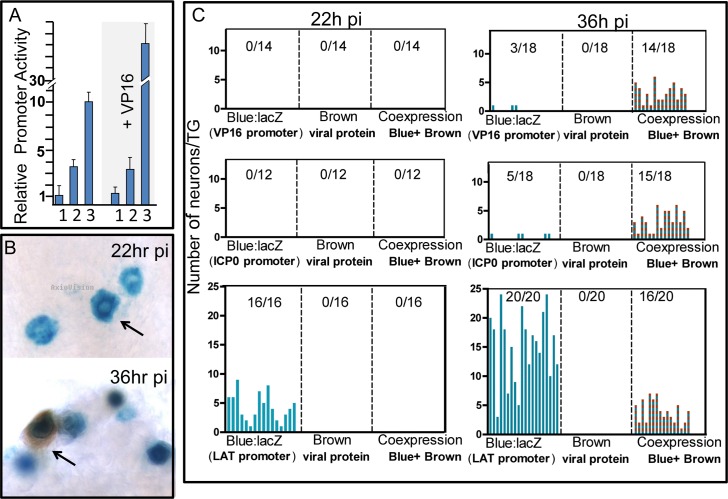
Quantification of viral lytic and acute stage latency gene transcription in individual neurons at very early times pi.A. Relative promoter strength was assayed by transfection of rabbit skin cells with the constructs employed to generate the viral promoter/reporter mutants and analysis of the amount of b-gal determined with a CPRG assay as detailed in methods. Transfection efficiencies were normalized by including a renilla luciferase plasmid in the assay. Lane 1 = LATpLacZ, 2 = VP16pLacZ, 3 = ICP0pLacZ. The LAT promoter was the weakest and the levels of expression of this construct were set to one. Where indicated, a VP16 expressing plasmid was included in the transfections. Each bar represents the average of 3 transfection experiments of 3 wells each. B. Photomicrographs of TG from mice infected with17LATpLacZ processed for LATp activity and viral protein expression. At 22 hrs pi, expression was restricted to the LATp. A 36 hrs, viral proteins are expressed but restricted to a subset of neurons that are marked by LATp activity. C. At the indicated times pi, eyes and TG were harvested. Unsectioned TG were processed for the histochemical detection of b-gal activity and IHC detection of viral proteins as detailed previously [4,11,48,54,78,81]. Bars represent the number of neurons positive in an individual TG. The number of TG positive over the number tested in each group is indicated. All TG tested from mice infected with 17LATpLacZ contained one or more neurons positive for b-gal activity at 22 hrs pi, whereas no TG infected with the lytic stage promoter reporter viruses were positive (p≤0.0001, ANOVA). At 36 hrs pi a subset of ganglia examined contained neurons positive for both b-gal and viral protein. The number of ganglia positive and the number of positive neurons in the TG was not different between groups (p≥0.5, ANOVA). Importantly, all neurons positive for viral protein were also positive for LAT promoter activity in the 17LATpLacZ group.